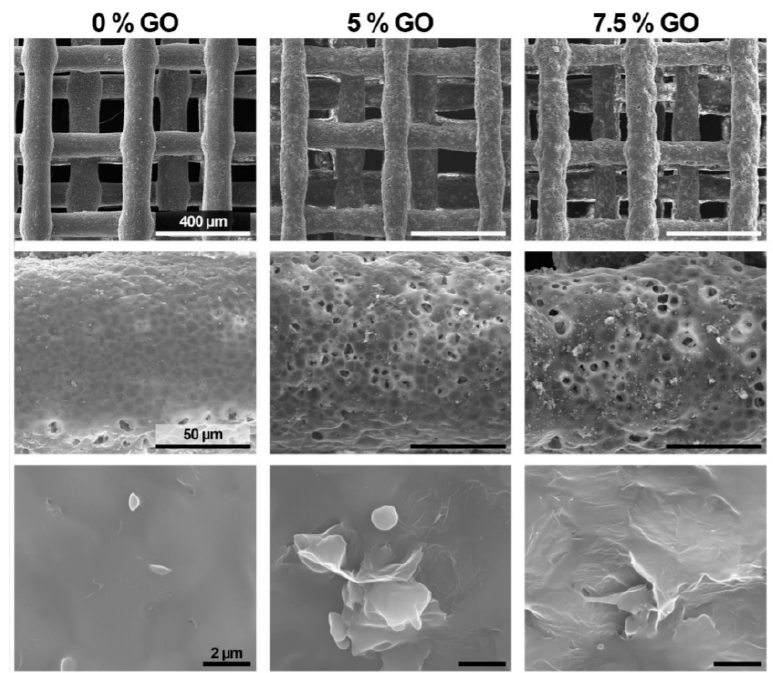
Figure 7. SEM images of PCL scaffolds with different percentages of Graphene oxide (GO), manufactured by Fused Deposition Modeling (FDM). Surface roughness and irregularity increased with the addition of GO. The average diameter of the fibres did not change with GO (reprinted from [260], with permission from Elsevier).